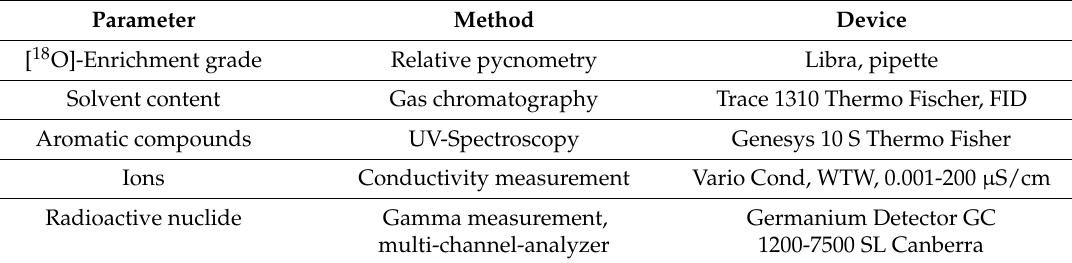
Table 2. Examination parameters for the quality control of [ 18